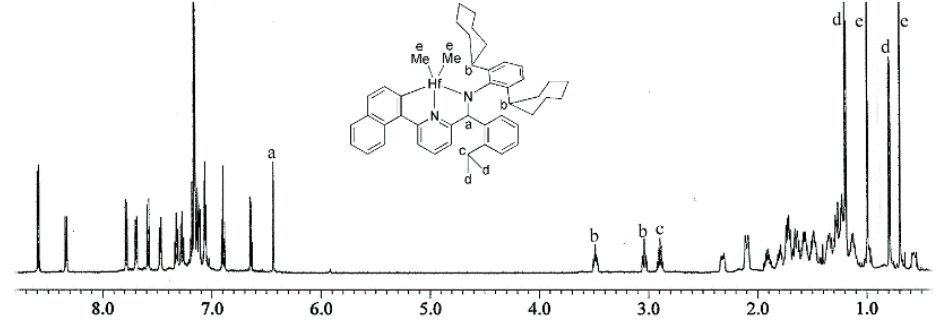
Figure 1. The 1H NMR spectrum of 19.